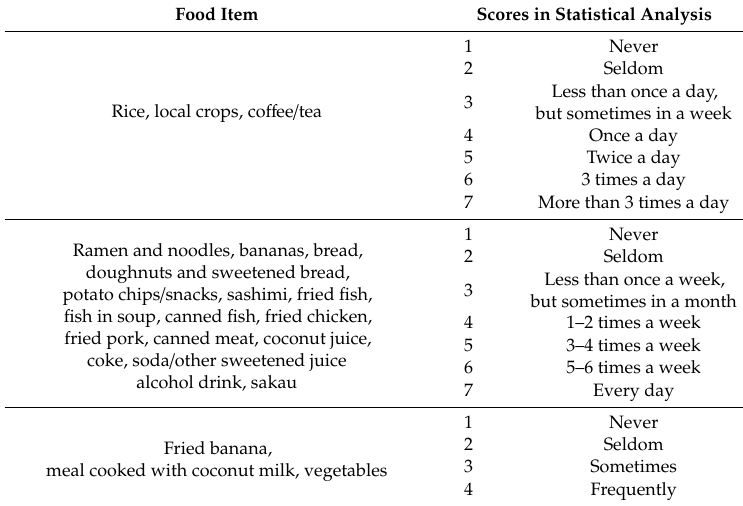
Food items and scores used at interview and statistical analysis of food frequency questionnaire (FFQ). Food